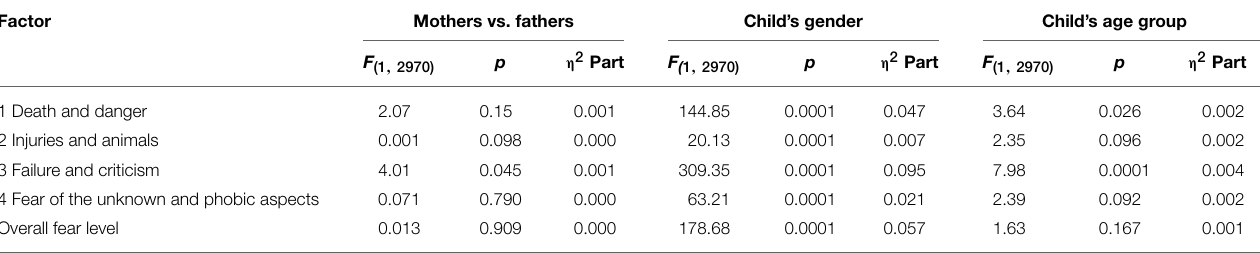
TABLE 3 | Analysis of Variance for principal effects of parental role (mothers vs. fathers), child’s gender and age group ( N = 2970 ) (interactions are not included). Factor Mothers vs. fathers Child’s gender